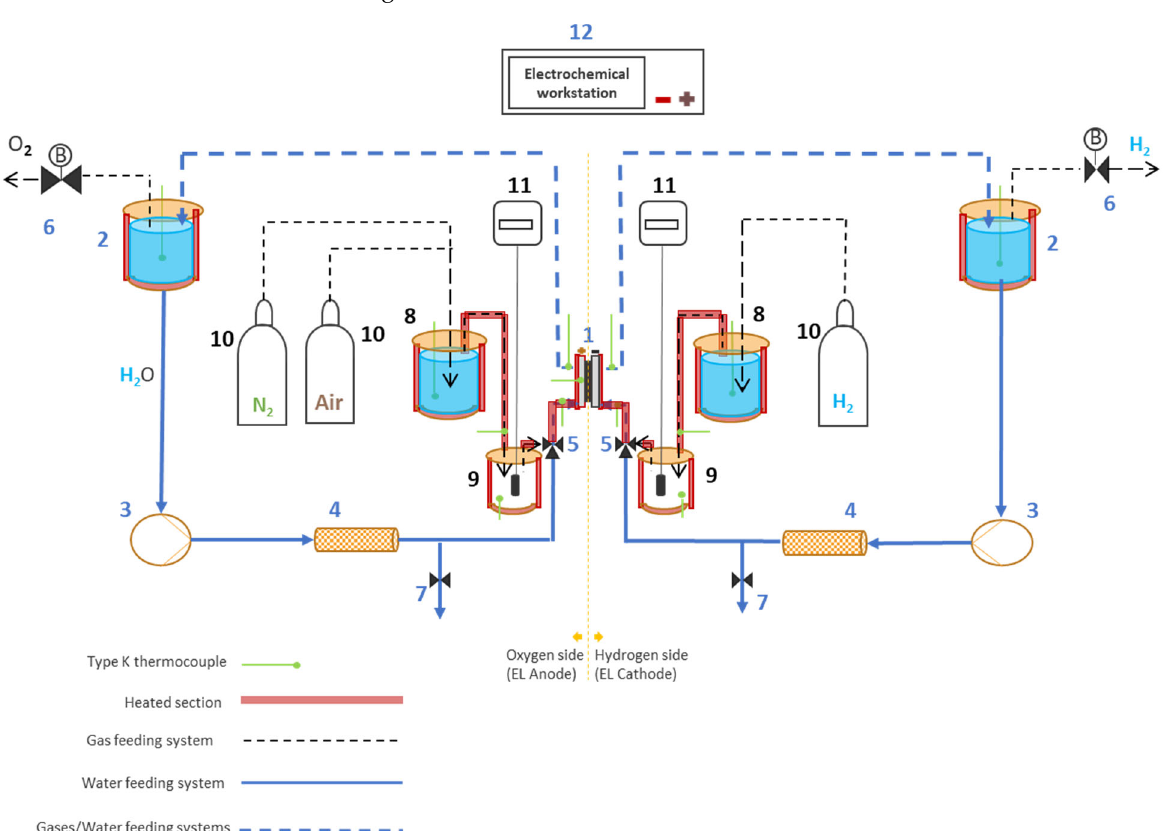
Figure 2. Scheme of the PEM WE test setup: (1) PEM electrolyzer, (2) water feeding tank, (3) peristaltic pump, (4) ion exchanger, (5) three ‐ way valve, (6) back pressure regulator, (7) water refill/discharge valve, (8) humidification tank, (9) humidity sensor tank, (10) compressed hydrogen, N 2 and air, (11) humidity probe and (12) electrochemical workstation